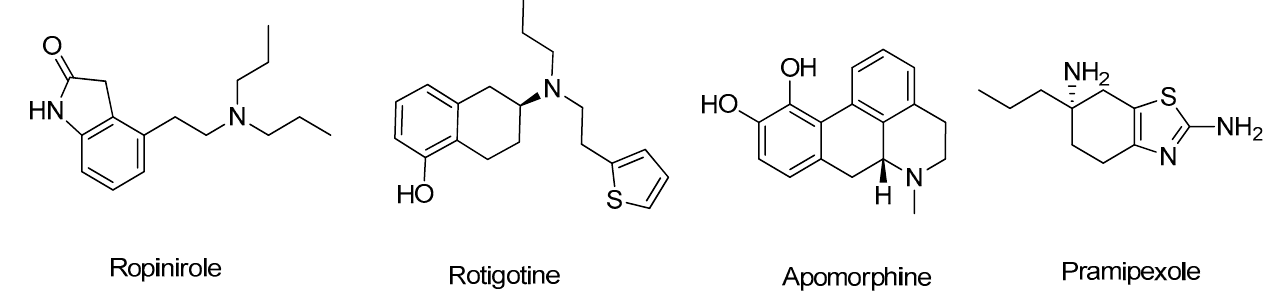
Figure 18. Structures of the ergoline class clinically approved DA.